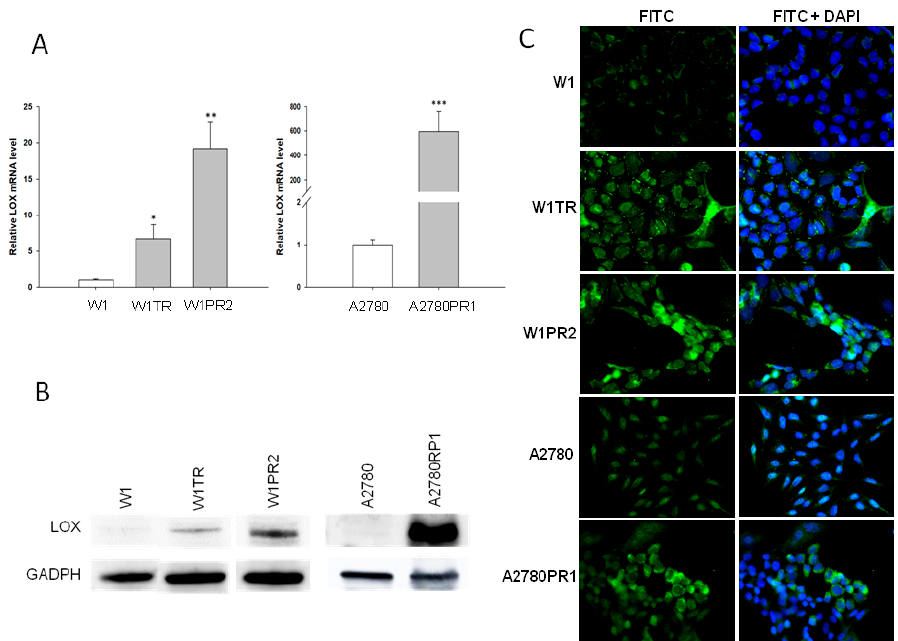
Figure 1. Expression analysis of ( A ) LOX transcript (Q-PCR) in the W1, A2780, and drug-resistant cell sublines. The figure presents the relative gene expression in the resistant cell lines (gray bars) with respect to that in the sensitive cell line (white bars), which has been assigned a value of 1. The values were considered significant at * p < 0.05, ** p < 0.01, and *** p < 0.001. ( B ) LOX protein expression analysis in the W1, A2780, and drug-resistant cell lines. The cellular proteins were separated using 7% PAGE and transferred to a PVDF membrane, which was then immunoblotted with either primary Ab or HRP-conjugated secondary Ab. A primary anti-GADPH Ab was used as a loading control for the cell lysates. ( C ) LOX immunofluorescence in the W1 and A2780 drug-resistant cell sublines. LOX was detected using the anti-LOX antibody and Alexa Fluor ® 488-conjugated secondary antibody (green). To visualize the cell nuclei, the cells were mounted with a DAPI-containing mounting medium (blue). Objective 40×.